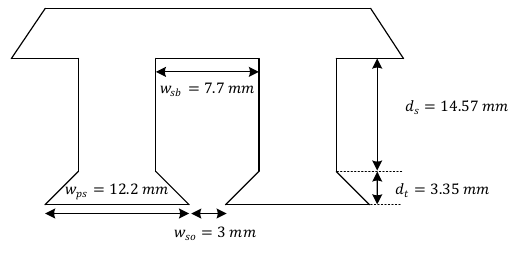
Figure 1. Slot dimensions on armature segment.